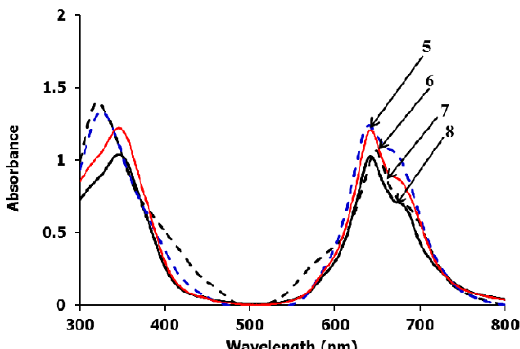
Ground state electronic absorption spectra of 5 , 6 , 7 and 8